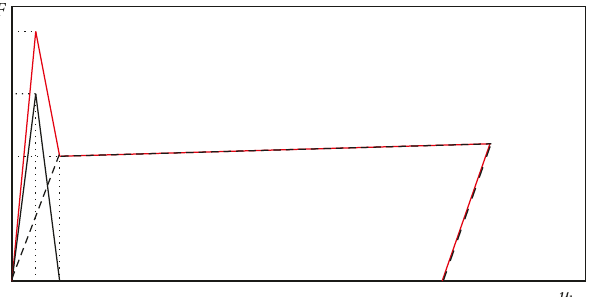
Figure 4: General shape of barge bow force-deformation curve. , curve 1; , curve 2; , curve 3.